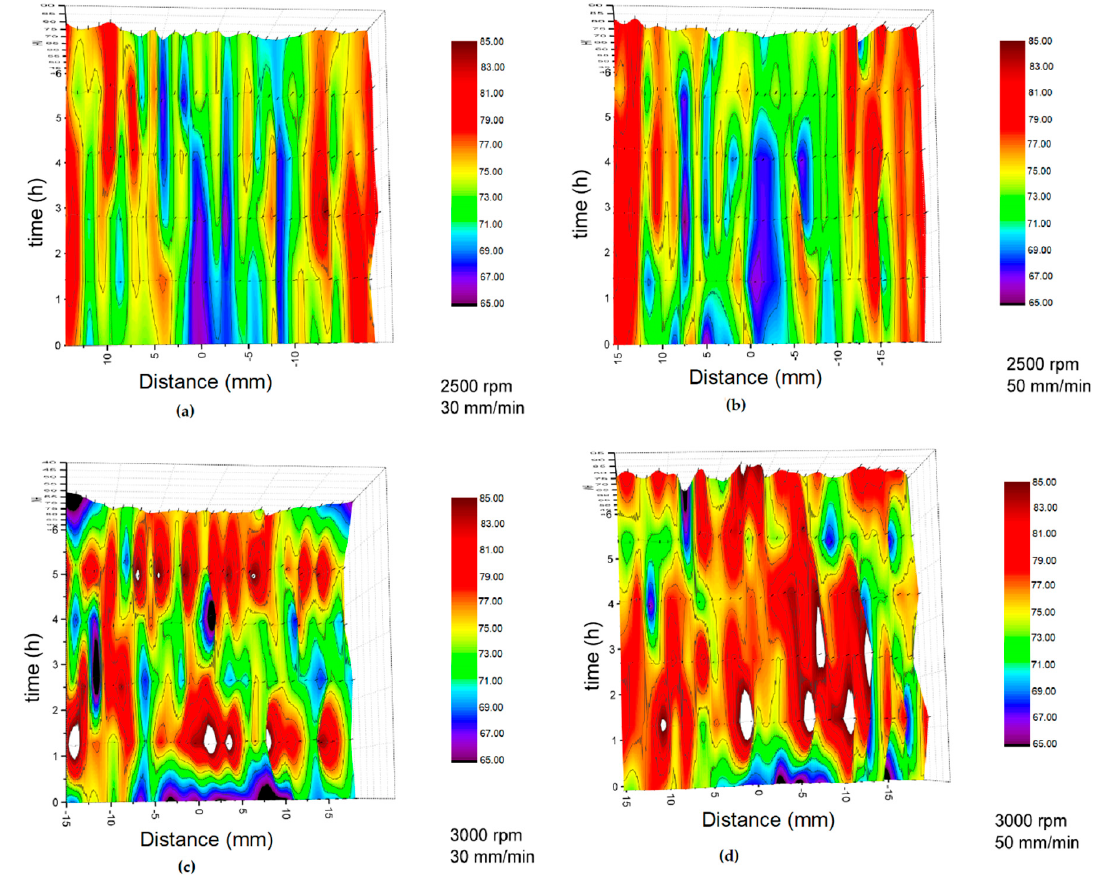
Figure 5. 3D microhardness profiles measured after aging at 300 °C in samples FSPed at ( a ) 2500 rpm , 30 mm / min; ( b ) 2500 rpm, 50 mm / min; ( c ) 3000 rpm, 30 mm / min; ( d ) 3000 rpm, 50 mm / min. Vickers microhardness (HV) profiles are plotted as function of distance from the nugget center (horizontal axis) and at different times (h). The color bands represent HV levels. White regions have hardness > 85 HV.